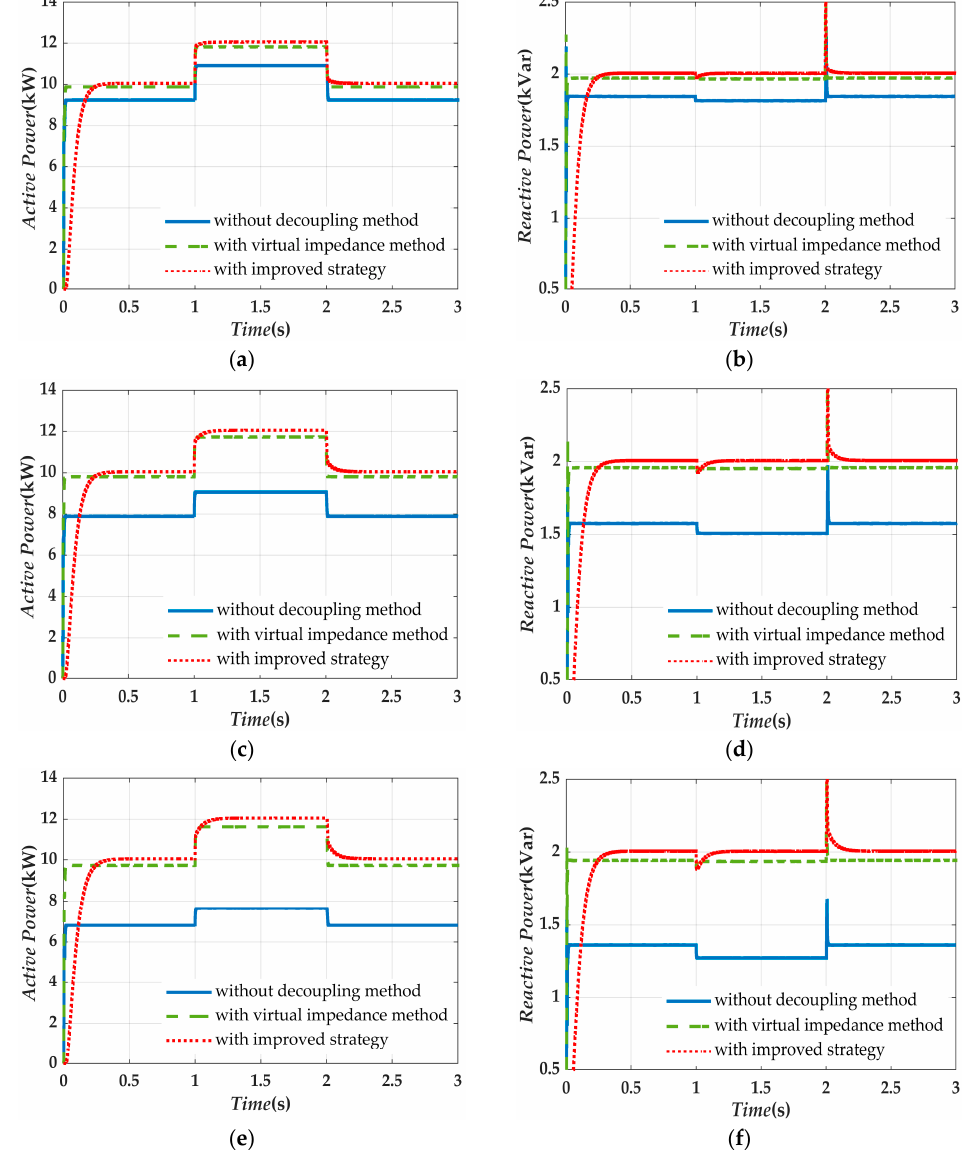
Figure 7. Waveforms of terminal active and reactive power of connecting lines with different lengths: ( a ) active power at the terminal when line length is 1 km; ( b ) reactive power at the terminal when line length is 1 km; ( c ) active power at the terminal when line length is 3 km; ( d ) reactive power at the terminal when line length is 3 km; ( e ) active power at the terminal when line length is 5 km; ( f ) reactive power at the terminal when line length is 5 km.